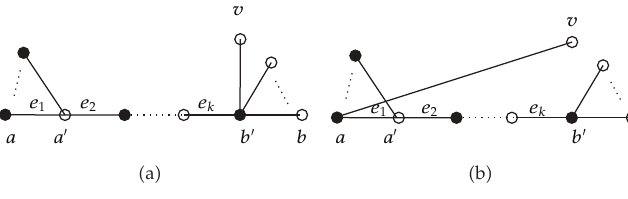
Figure 3: T (cid:2) a (cid:3) and T (cid:8) (cid:2) b (cid:3) in the proof of Subcase 2 of Claim